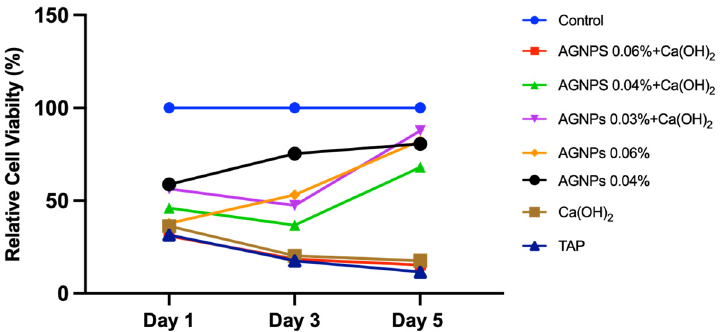
Figure 5. Relative cell proliferation compared with control (cells without treatment) as measured by AlamarBlue assay on days 1, 3, and 5 post-treatment. [Ca(OH) 2 : Calcium hydroxide, AgNPs: Silver nanoparticles, TAP: Triple antibiotic paste]. nanoparticles, TAP: Triple antibiotic paste].